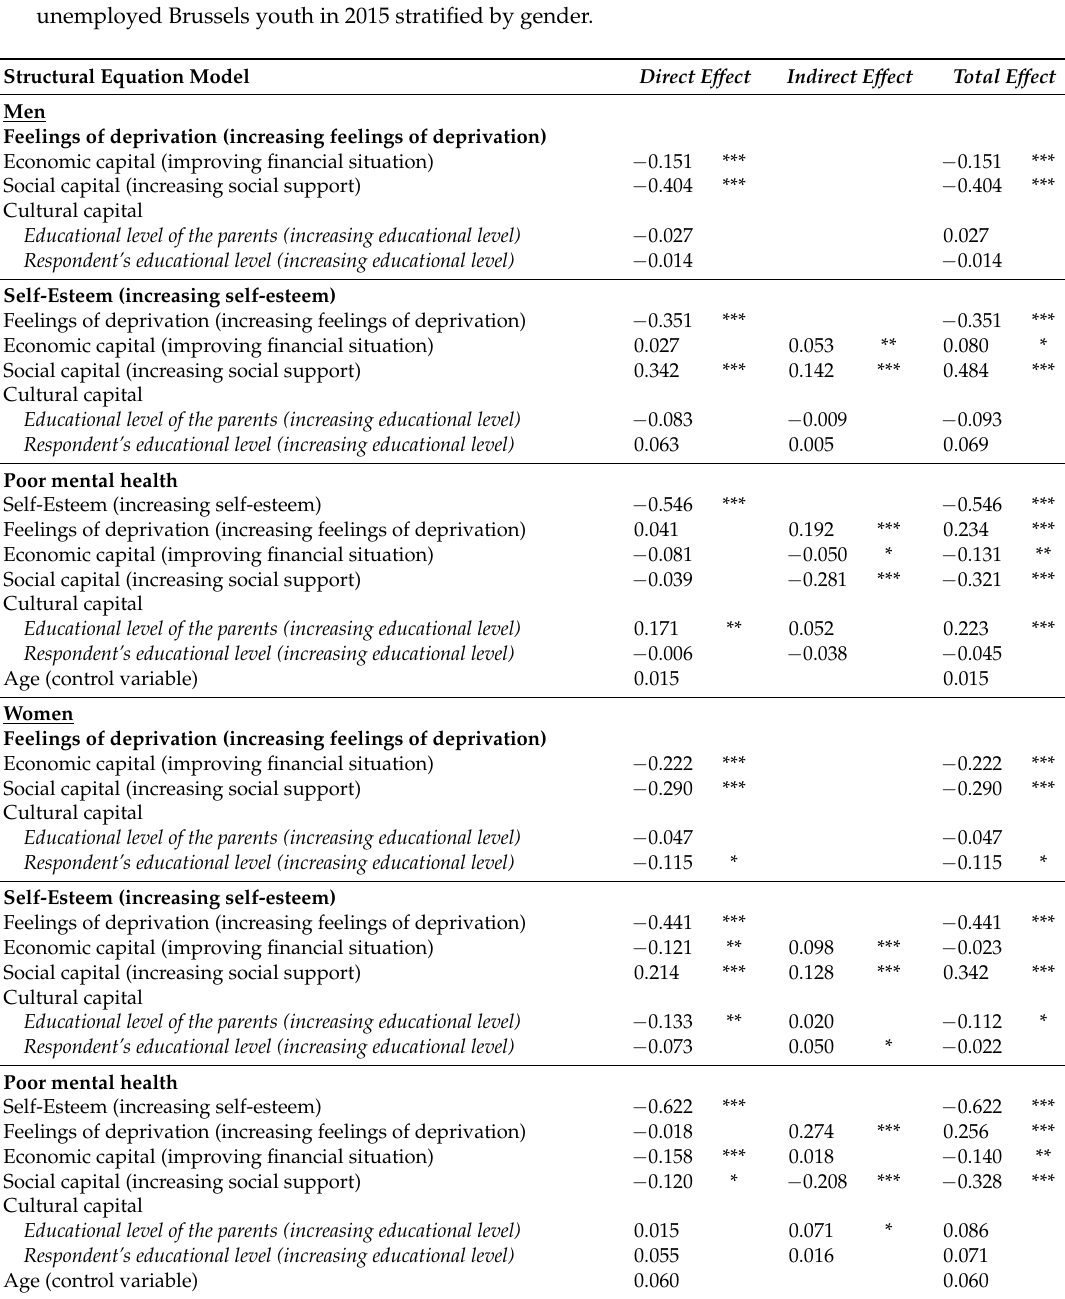
Table 4. Standardised results of a multi-group structural equation model on the mental health of unemployed Brussels youth in 2015 stratified by